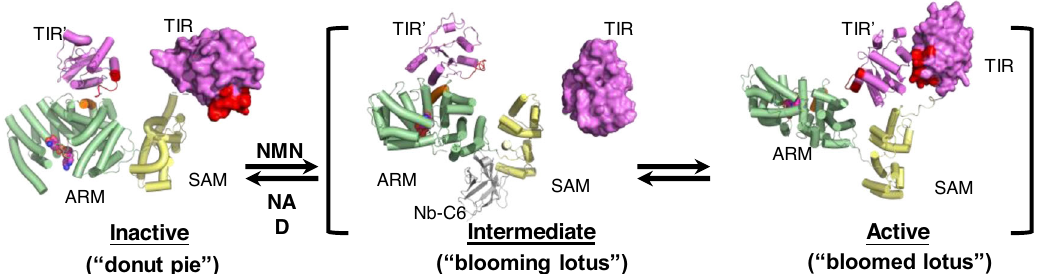
Fig. 7 | A proposed model for the transition between the inactive and active statesofSARM1. SARM1wasshownwiththeARMdomainingreen,SAMdomainin yellow, and TIR domain in magenta. TIR ’ is the domain from a neighboring SARM1